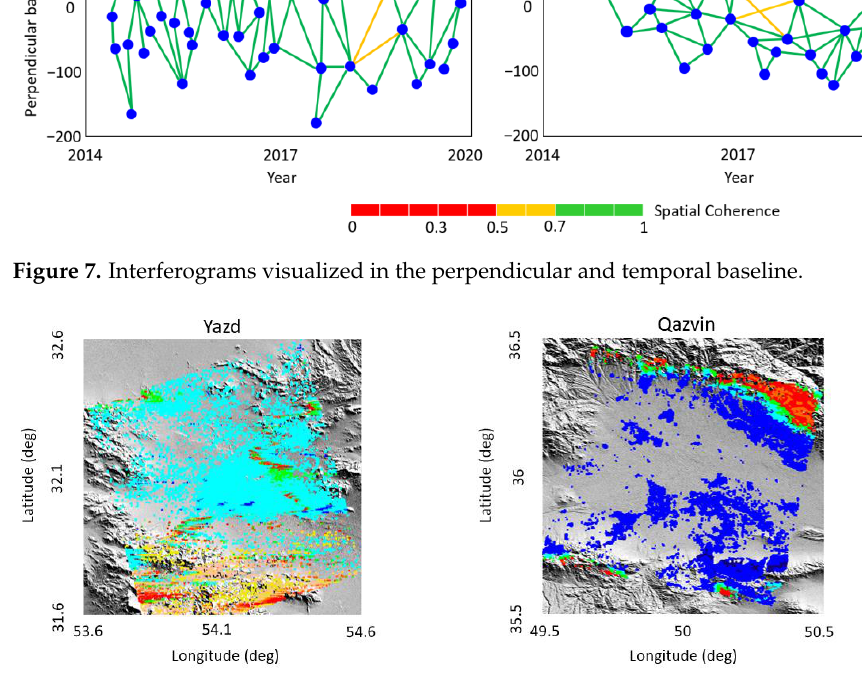
Figure 9. Line-of-sight direction displacement velocity maps of two areas. The black star and circles show the location of the reference point and wells, respectively, and the blue square indicates the location of GPS and synoptic stations . The computed displacement velocity in the Yazd region indicates a subsidence signal at the center of this area. The amount of the subsidence reaches 150 mm/year, which is considered to be a high and dangerous rate. There is no significant displacement in other parts of the area. In the Qazvin area, the subsidence signal is clearly visible. The maximum